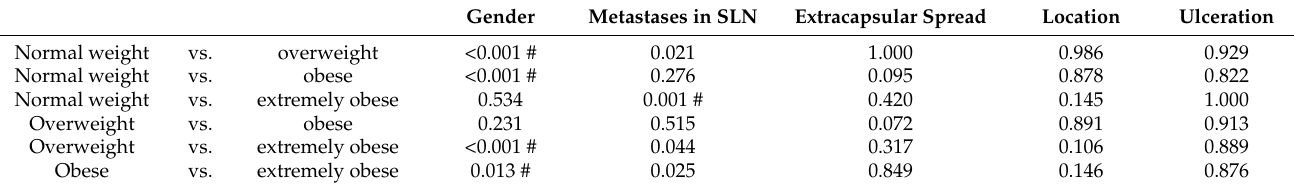
Table 4. p -values of the pairwise comparisons (Fisher-test).